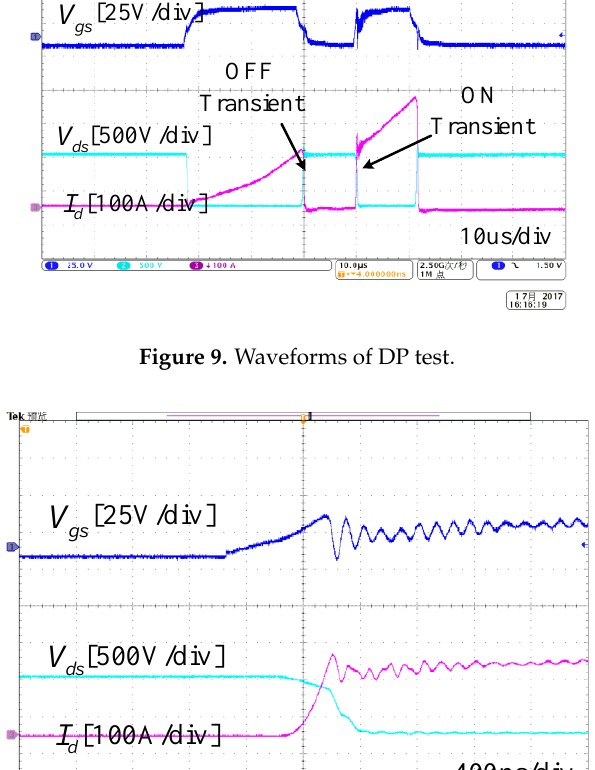
Figure 10. Turn-on characteristics with 𝑅 𝑔 = 15 Ω and 𝑇 𝑗 = 125 ℃ .